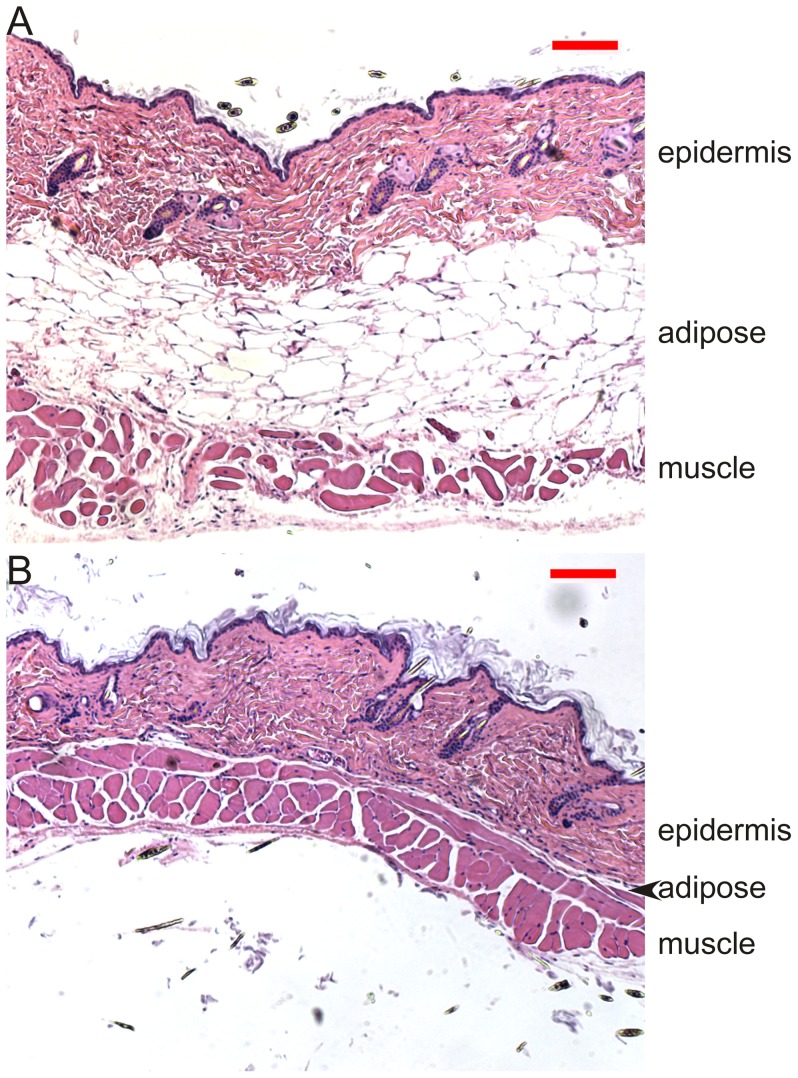
Skin Histology.Dorsal skin sections from HF control (A) and KO (B) mice were fixed, paraffin embedded, sectioned at 10 µm and stained with Hematoxylin and Eosin; bar, 100 µm.